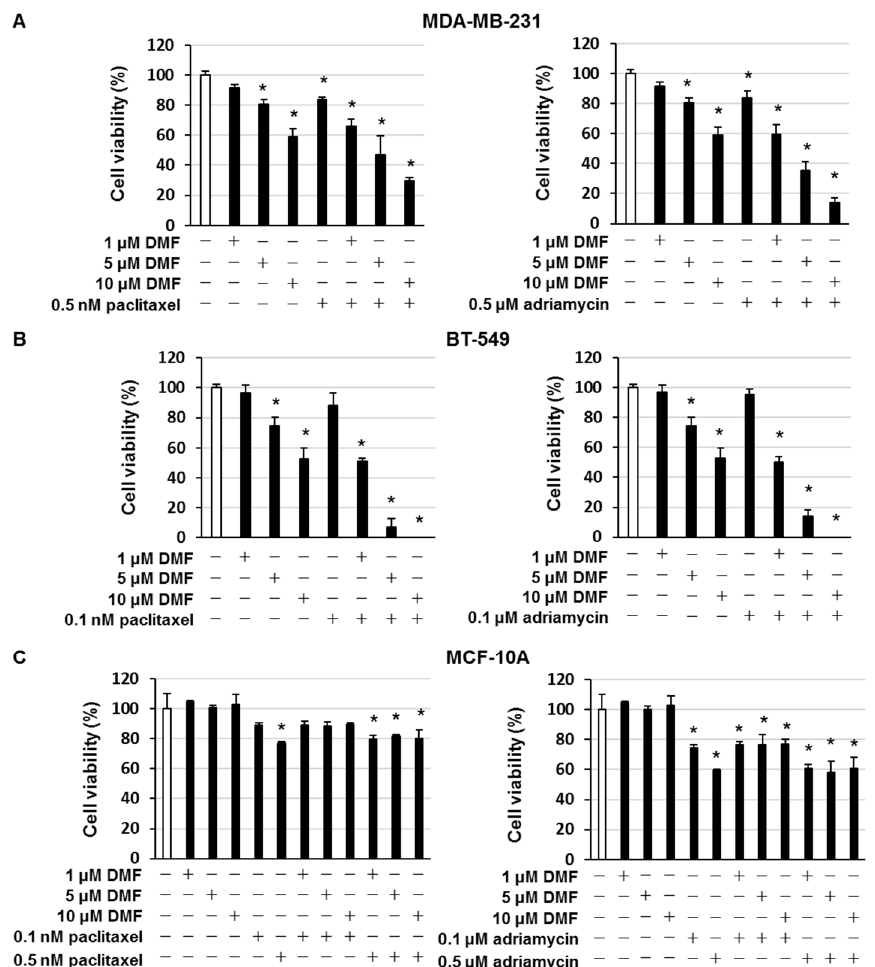
Figure 5. DMF enhanced the cytotoxic effect of paclitaxel and adriamycin in TNBC cells. ( A ) MDA- MB-231, ( B ) BT-549, and ( C ) MCF-10A cells were treated with the shown concentrations of DMF and paclitaxel or adriamycin. After incubation for 72 h, the number of dead cells was quantified using the trypan blue staining assay. The results are exemplary of five independent experiments. * p < 0.01 vs. untreated